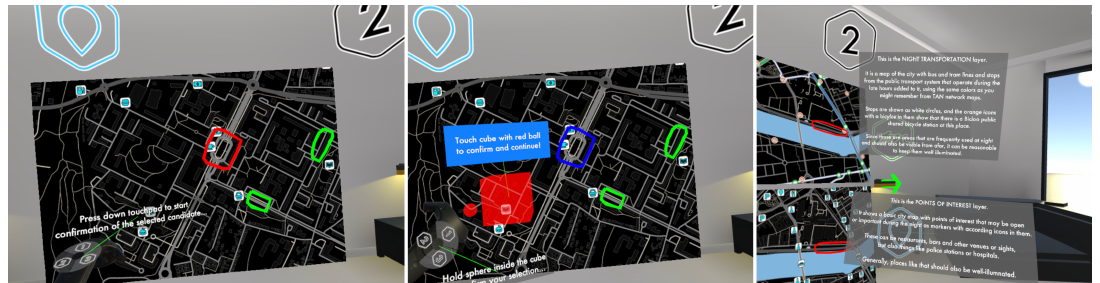
Figure 4. The interface for selecting and confirming candidate zones (( left ) and ( middle ), respectively), and optional information panels for the map layers ( right